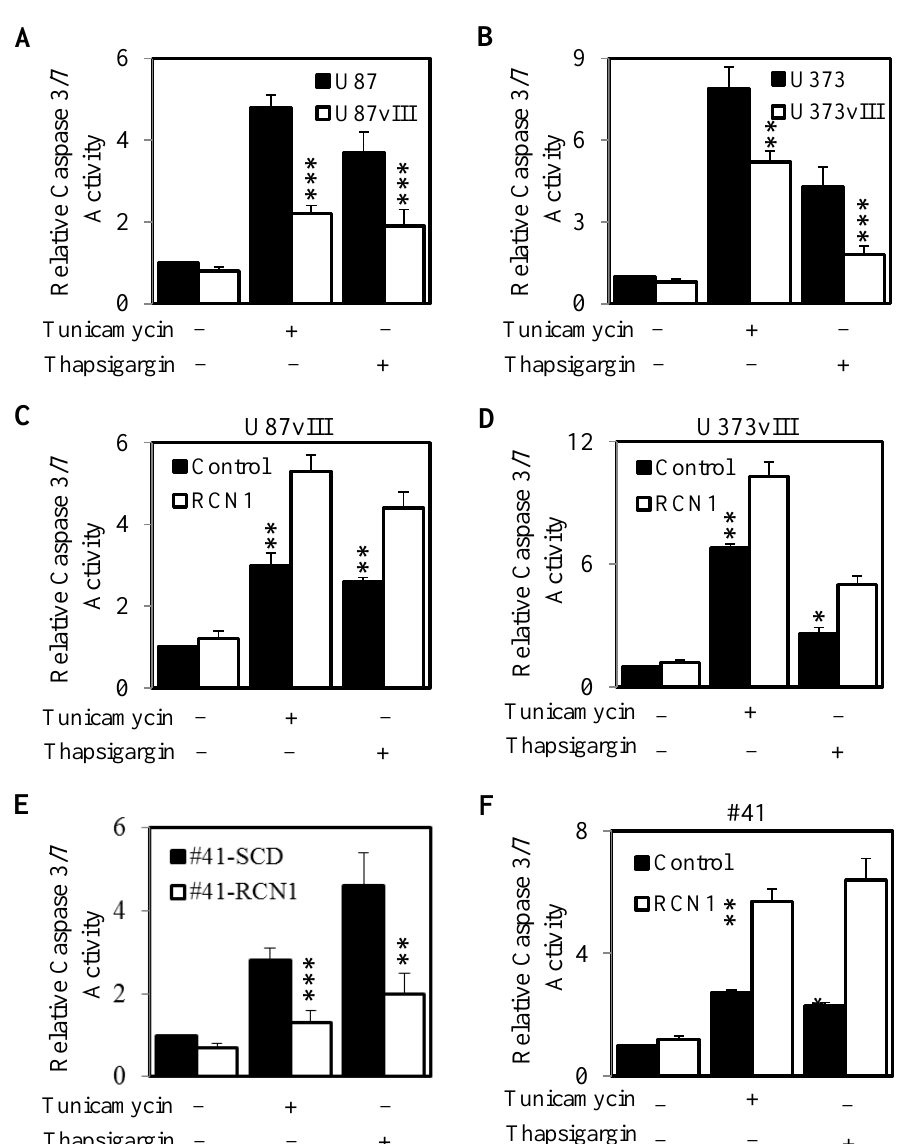
Figure 6. RCN1 expression inhibits caspase 3/7 activity. ( A ) U87 and U87vIII and ( B ) U373 and U373vIII cells were seeded and allowed to adhere overnight. Cells were then treated with ± tunicamycin (50 nM) or ± thapsigargin (50 nM) for a further 24 h, lysed and assessed for caspase 3/7 activity. Data are expressed as relative caspase 3/7 activity (fold change) by standardizing the caspase 3/7 activity of the control untreated cells to 1, and accordingly normalizing all other raw values. ( C ) U87vIII and ( D ) U373vIII cells were transfected with either control ( (cid:4) ) or RCN1 ( (cid:3) ) siRNA and allowed to adhere overnight. Cells were then treated with ± tunicamycin or ± thapsigargin for a further 24 h, lysed and assessed for caspase 3/7 activity. Data are expressed as relative caspase 3/7 activity (fold change) by standardizing the caspase 3/7 activity of the control siRNA, control treated cells to 1, and accordingly normalizing all other raw values. ( E ) #41-SCD and #41-RCN1 cells were seeded and allowed to adhere overnight. Cells were then treated with ± tunicamycin or ± thapsigargin for a further 24 h, lysed and assessed for caspase 3/7 activity as outlined above. ( F ) #41 cells were transfected with either control or RCN1 siRNA allowed to adhere overnight. Cells were then treated with ± tunicamycin (50 nM) or ± thapsigargin (50 nM) for a further 24 h, lysed and assessed for caspase 3/7 activity as outlined above. * p < 0.05; ** p < 0.01; *** p <